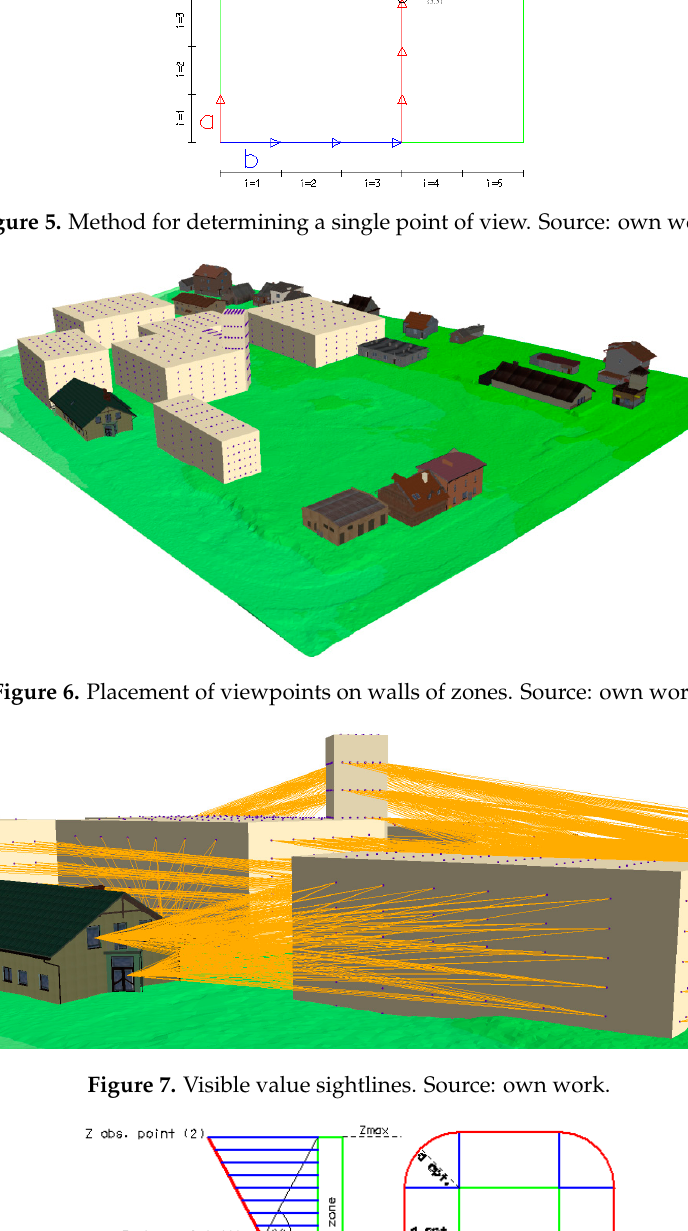
Figure 7. Visible value sightlines. Source: own work